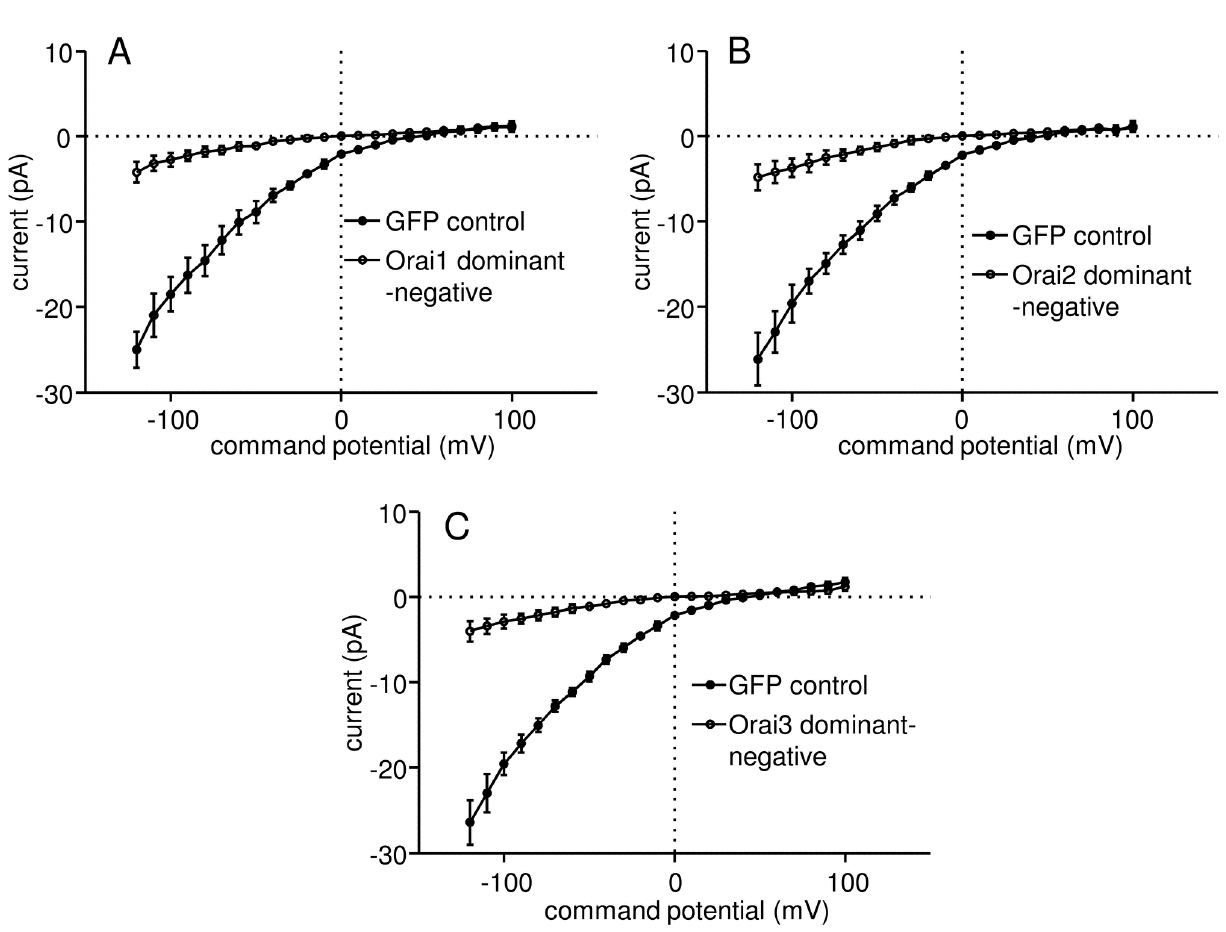
Figure 5. Expression of dominant negative mutations of Orai1-3 greatly reduce Ca 2+ influx into activated HLMCs. Subtracted whole cell patch clamp current-voltage (I–V) curves from HLMCs transduced with recombinant